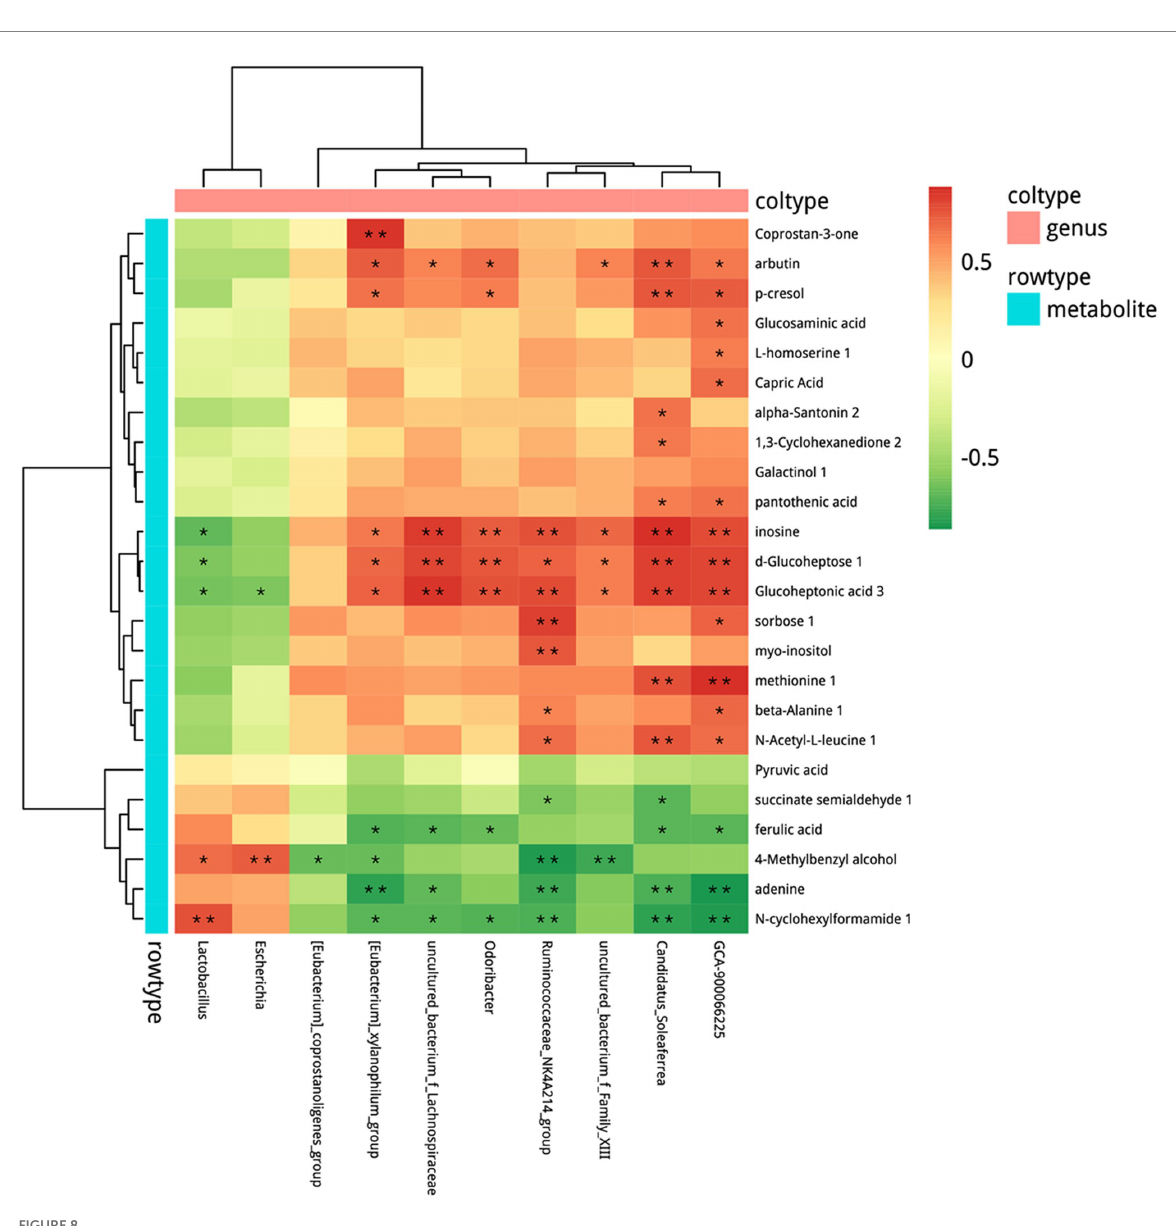
FIGURE 8 Combined analysis of metabolomics and microbiome. Spearman’s rank correlation. * p < 0.05, ** p < 0.01. n =